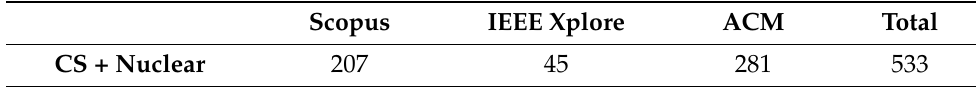
Table 1. Results of the literature search from each online database.